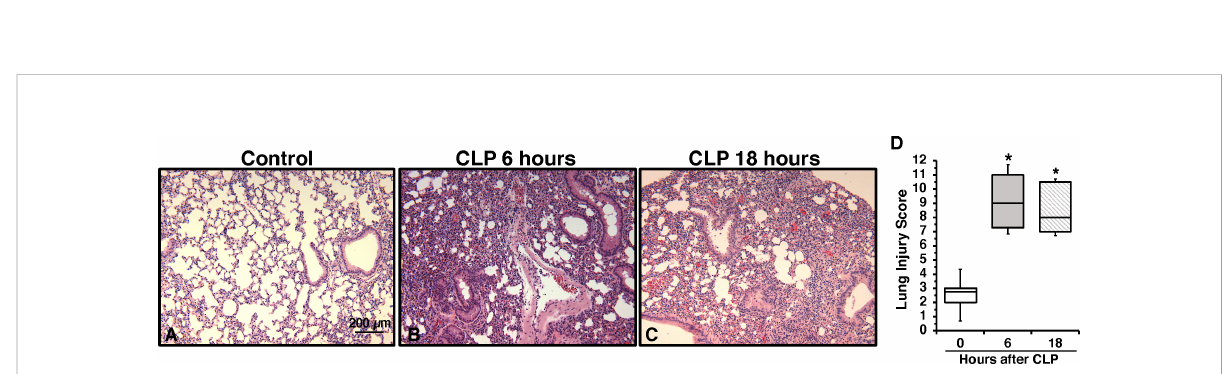
FIGURE 2 Representative histology photomicrographs of lung sections of a control mouse (A) or mice subjected to polymicrobial sepsis at 6 h (B) and 18 h (C) after cecal ligation and puncture (CLP). Lung damage at 6 h and 18 h after CLP was characterized by severe reduction of alveolar space, neutrophil adhesion along vascular wall, hemorrhage, and in fi ltration of in fl ammatory cells. Magni fi cation x100. A similar pattern was seen in tissue sections of n=5 mice in each experimental group. (D) Histopathologic scores of lung sections (n=5 mice for each group). Lung injury was scored from 0 (no damage) to 16 (maximum damage). Box plots represent 25 th percentile, median, and 75 th percentile; error bars de fi ne 10 th and 90 th percentiles. *Represents P < 0.05 versus control mice at time 0.